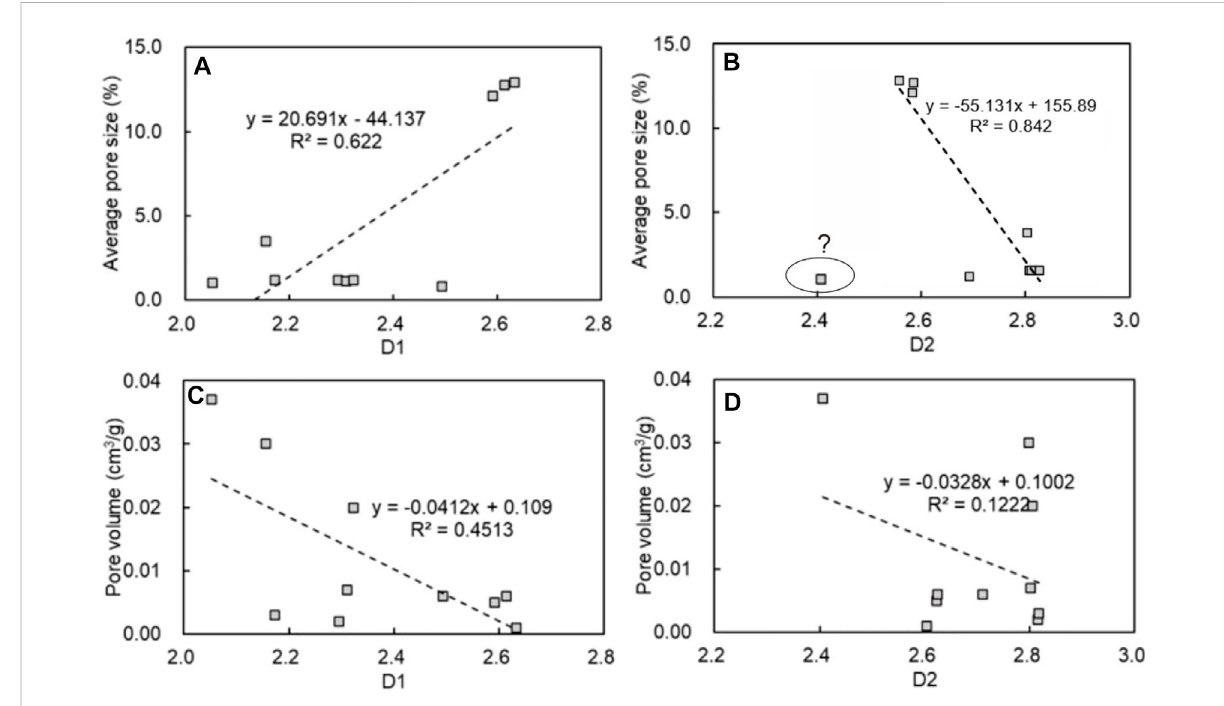
FIGURE 12 Relationship between pore structure and fractal dimension of shale